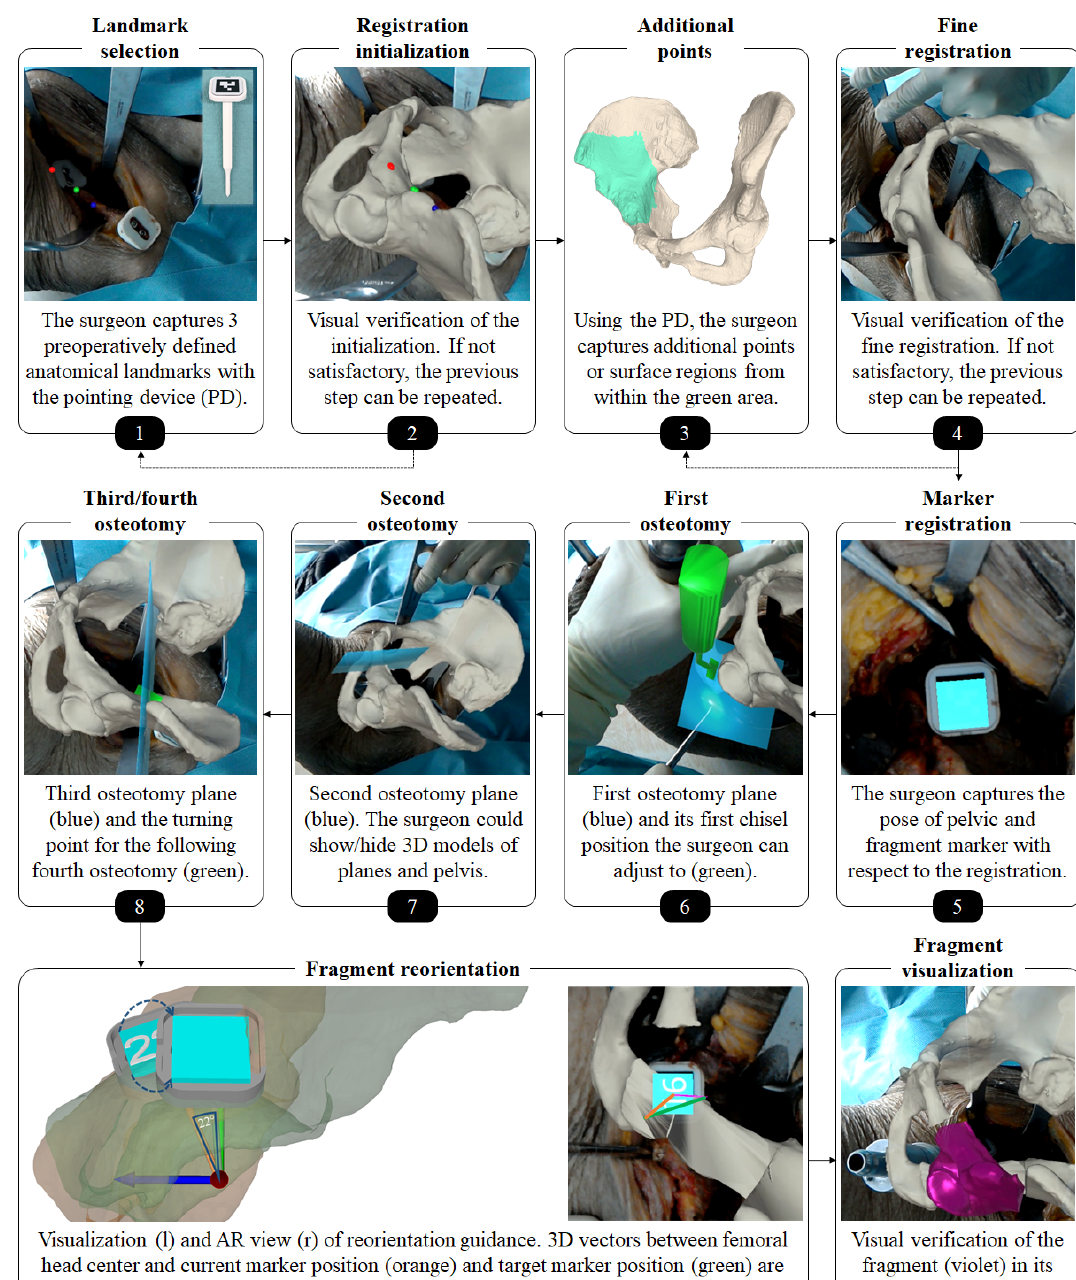
Figure 5. Workflow of the augmented reality (AR)-based surgical navigation. Please note that the pelvic bone in this image is shown opaque, as different rendering options could be chosen by the surgeon. The impression of visual misalignment is caused by the stereo-rendering technique which generates two images optimized to the left and right eye of the